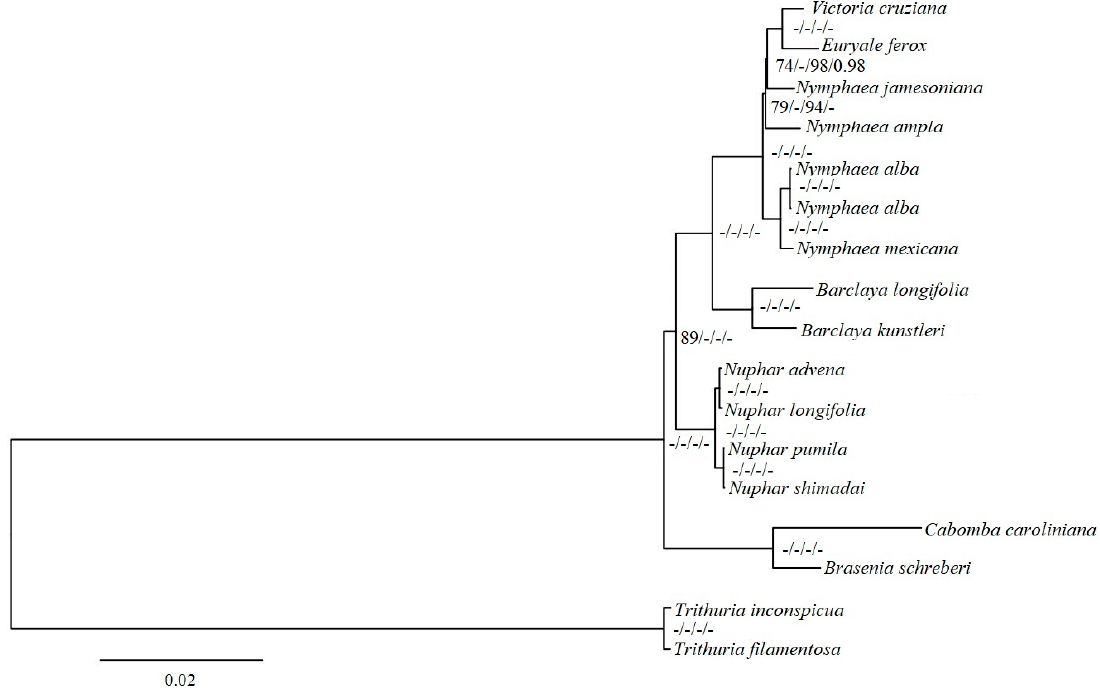
Figure 6. Phylogenetic relationships among the species of Nymphaeaceae, Cabombaceae, and Hydatellaceae (outgroup). The Maximum Likelihood (ML) and Bayesian Inference (BI) phylogenetic tree was based on 66 protein codon genes. The numbers indicate ML bootstrap support (100) and BI posterior probabilities (1.0) values. The - symbol indicates maximum support. The first two values and the last two are for unpartitioned data and partitioned data respectively.